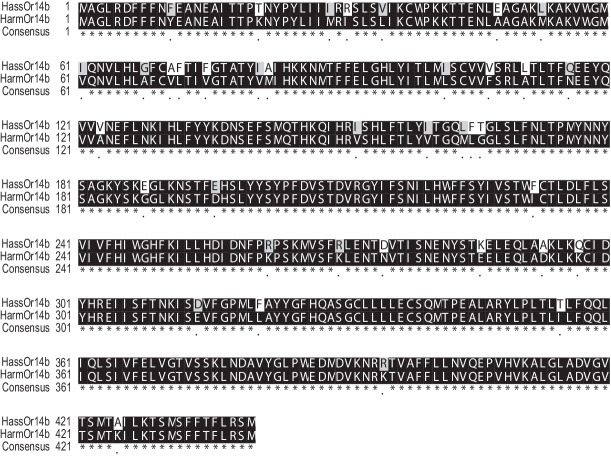
Alignment of amino acid sequences of HassOr14b and HarmOr14b.The same residues are marked by ‘*’, and the different residues are marked by ‘•’.